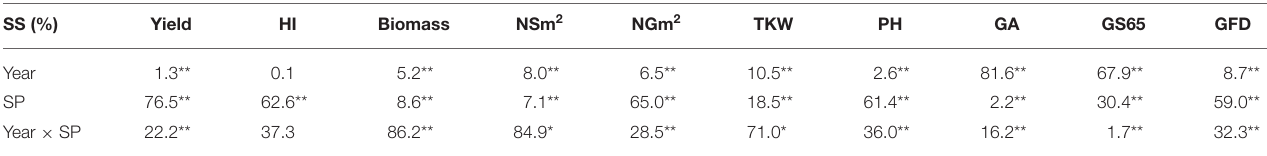
TABLE 3 | Analysis of variance for grain yield, harvest index (HI), biomass, number of spikes per square meter (NSm 2 ), number of grains per square meter (NGm 2 ), thousand kernel weight (TKW), plant height (PH), green area (GA), number of days from sowing to anthesis (A) (GS65), and grain filling duration (GFD, GS87) for the three years of field